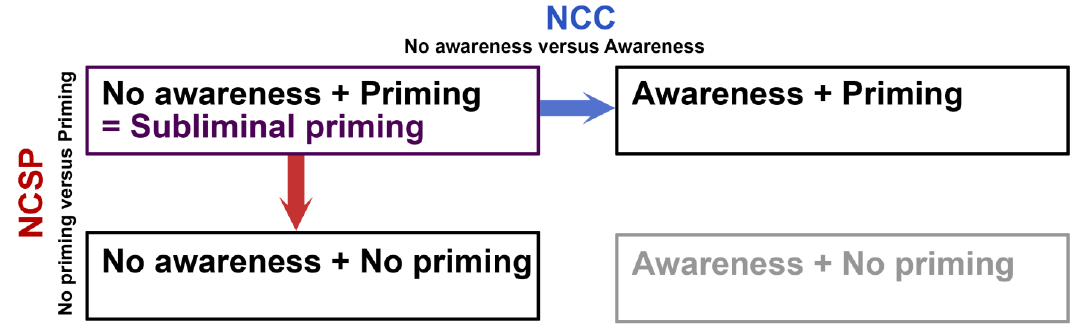
Figure 1. Subliminal perception in relation to NCC and NCSP. Subliminal priming is an interesting paradigm, because it entails the dissociation of visual awareness and behavioral impact, as measured by priming. Conditions of subliminal priming have mainly been compared to conditions of supraliminal priming (awareness and priming). This approach renders information about the neural correlates of consciousness (NCC). The opposite dimension reflects the contrast between subliminal priming and conditions in which the subliminal visual stimulus does not lead to priming. This approach can be informative with regards to the neural correlates of subliminal priming (NCSP). The fourth condition (awareness + no priming) is the situation that would theoretically complete the table, but it is implausible that awareness and priming could ever be actually dissociated like this and we therefore print it in gray